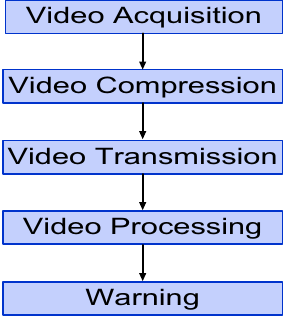
Fig. 1 Video surveillance systems block